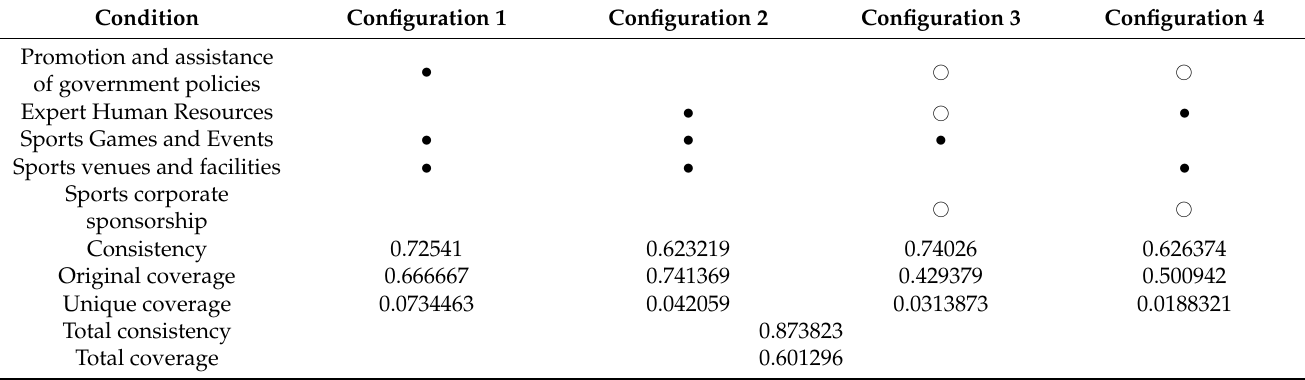
Table 4. A study of the long-term growth of sports consumer